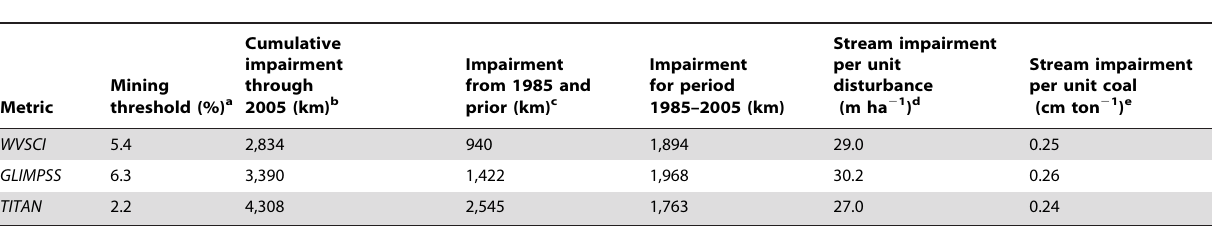
Table 1. Stream impairment estimates per unit coal produced.